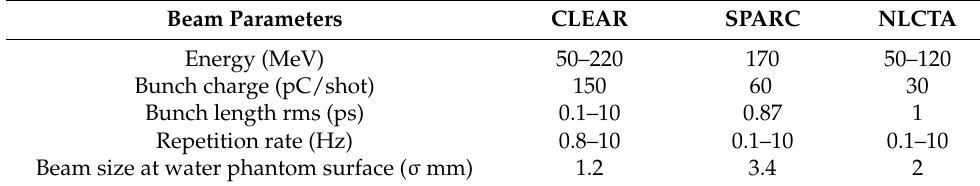
Table 1. Main parameters for the VHEE sources cited in this